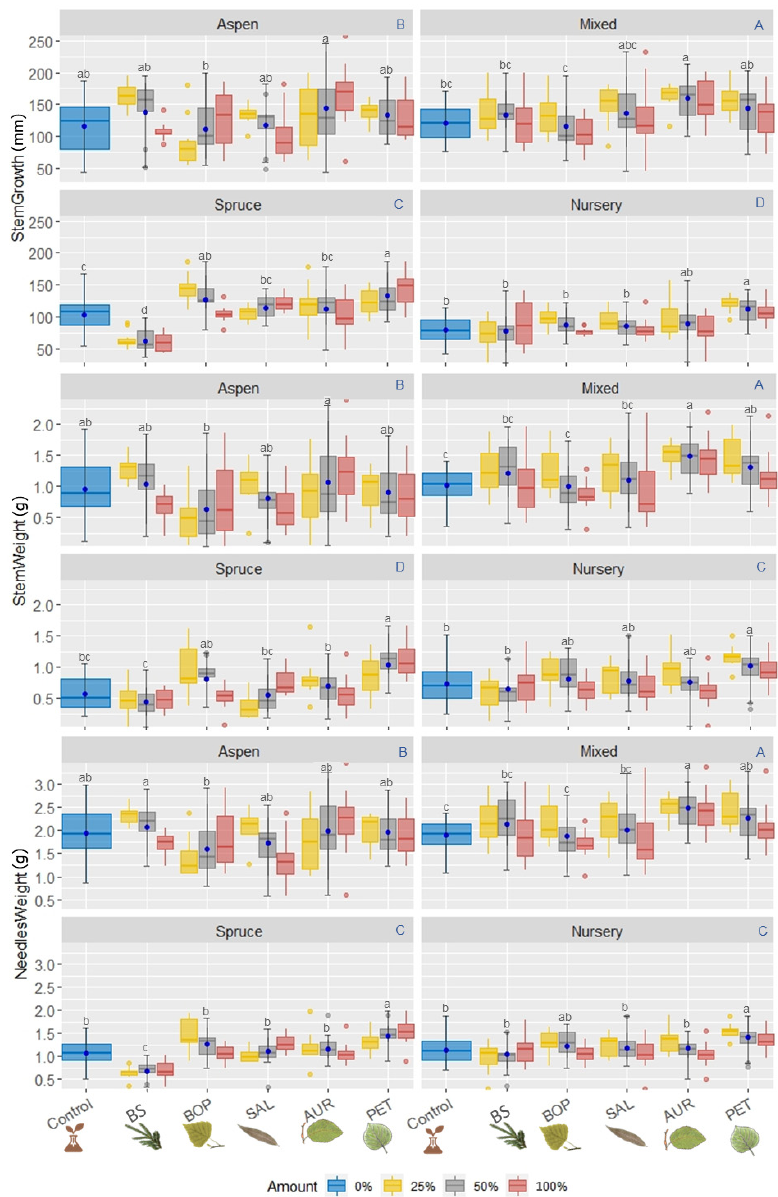
Figure 2. Boxplot of the aerial parts of B. spruce seedlings: the blue uppercase letters of each block of variables (i.e., StemGrowth, StemWeight and NeedlesWeight) correspond to multiple comparisons of treatments by means of Tukey test for the humus treatment (i.e., humus from pure stands of B. spruce, humus from pure T. aspen stands, humus from mixed B. spruce and T. aspen stands, and MFFP forest nursery soil); the black lowcase letters correspond to the Tukey test on different crushed leaf litter added to the surface of each humus treatment group, with their respective averages per litter group presented by the central circles of each group, and; the colored bars correspond to the percentage of litter addition/non-addition for each litter group. Different lowercase letter colors correspond to the type of litter added. Control: no litter addition; BS: B. spruce ; BOP: White birch ; SAL: Willow sp; AUR: Alder sp.; PET: T. aspen